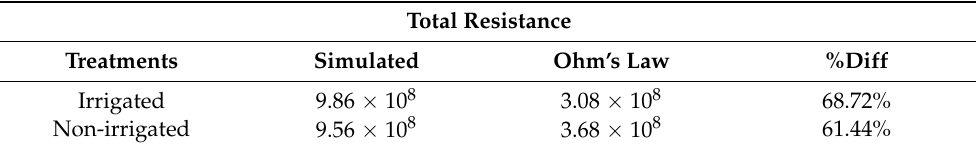
Table 2. Comparisons of the mean values of total vessel resistance between those simulated and calculated by Ohm’s law, and analysis of their percentage difference